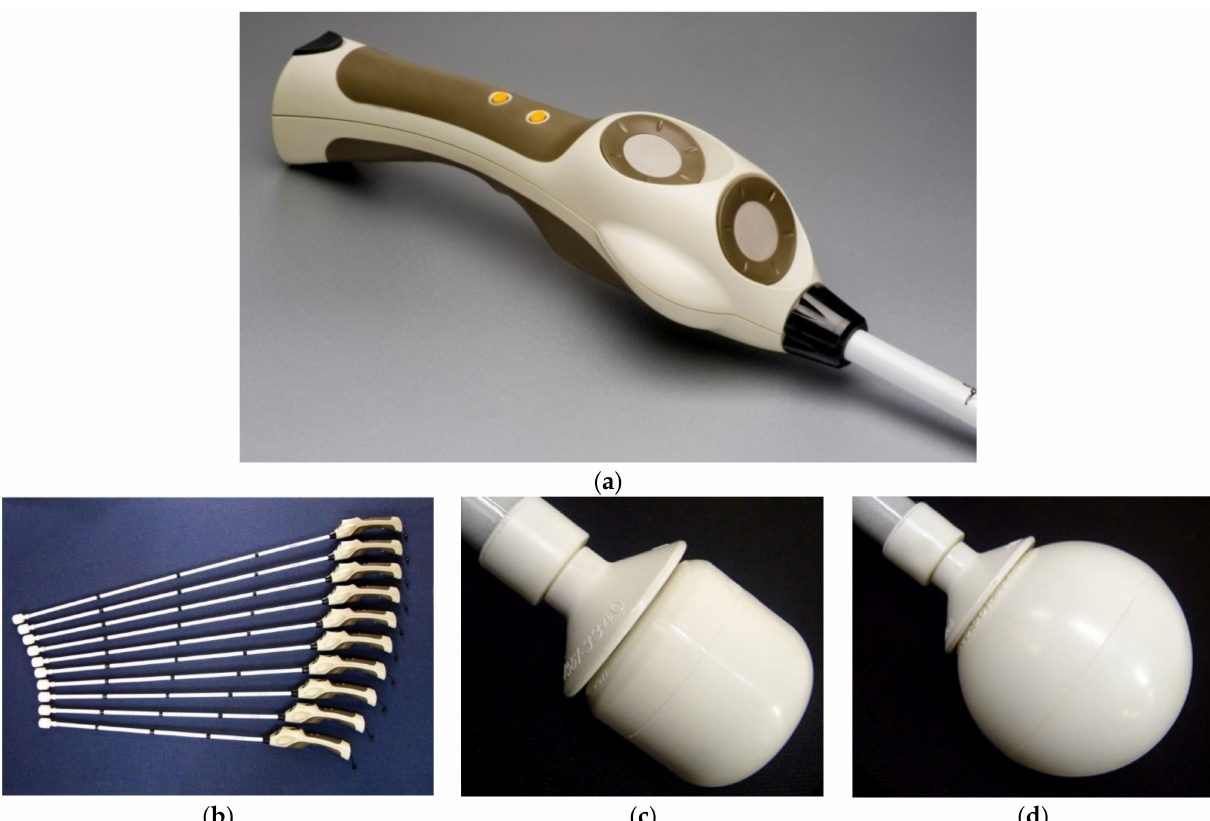
Figure 4. UltraCane stock photos [40]: ( a ) UltraCane smart handle; ( b ) different white cane sizes that can be chosen at the time of purchase; ( c ) customizable rolling “marshmallow” tip; and ( d ) customizable rolling sphere